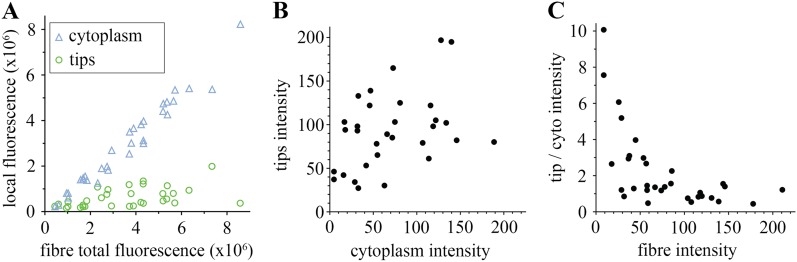
Comparison of tip and cytoplasm huDysGFP.(A) Variation of the total fluorescence (as raw integrated density or sum of pixel values) at tips (green circles) and cytoplasm (blue triangles) over a population of 32 fibres expressing huDysGFP. (B) Mean voxel intensity at tips versus cytoplasm in sum projection of confocal z-stacks. The mean voxel intensity is calculated as the integrated density per pixel in the sum projections, therefore taking into account the fibre and tip size. (C) Ratio tip/cytoplasm voxel intensities shows an inverse correlation with the total fibre voxel intensity in sum projections of confocal z-stacks. p value = 0.0004, R2 = 0.3443, n = 32.